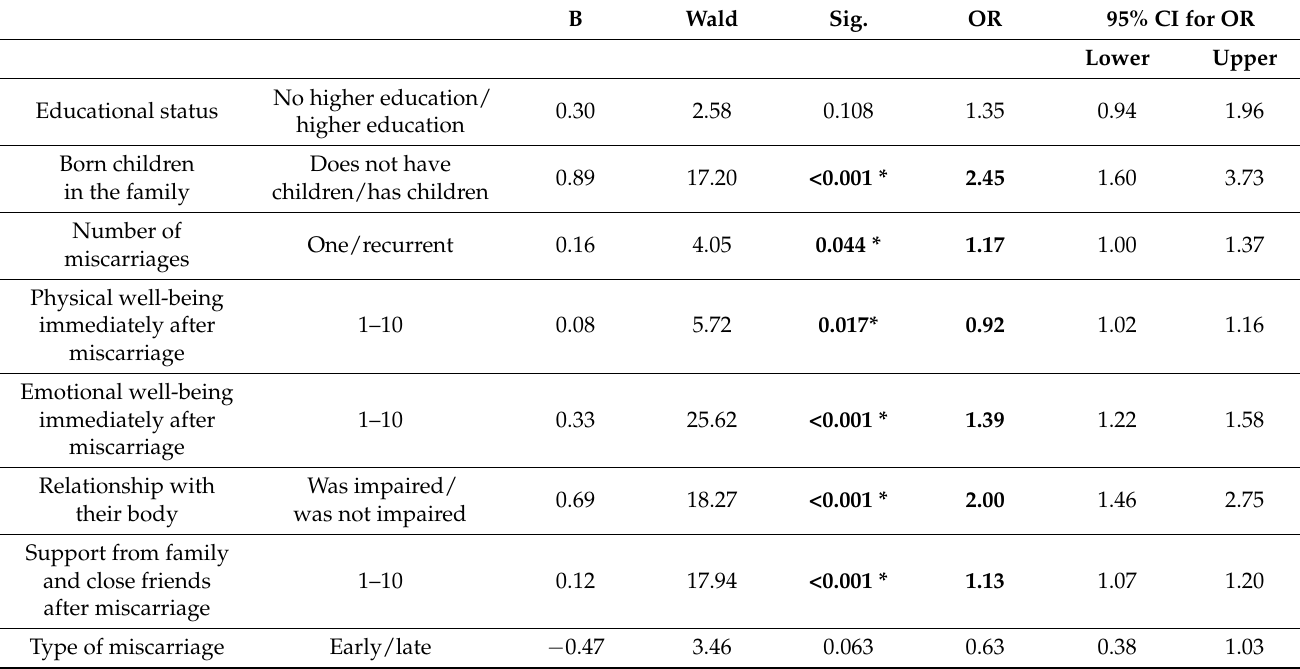
Table 3. Binary logistic regression model for present post-traumatic stress risk.